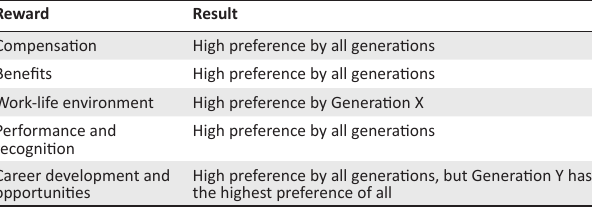
TABLE 13: Preferences in reward if offered by another company.